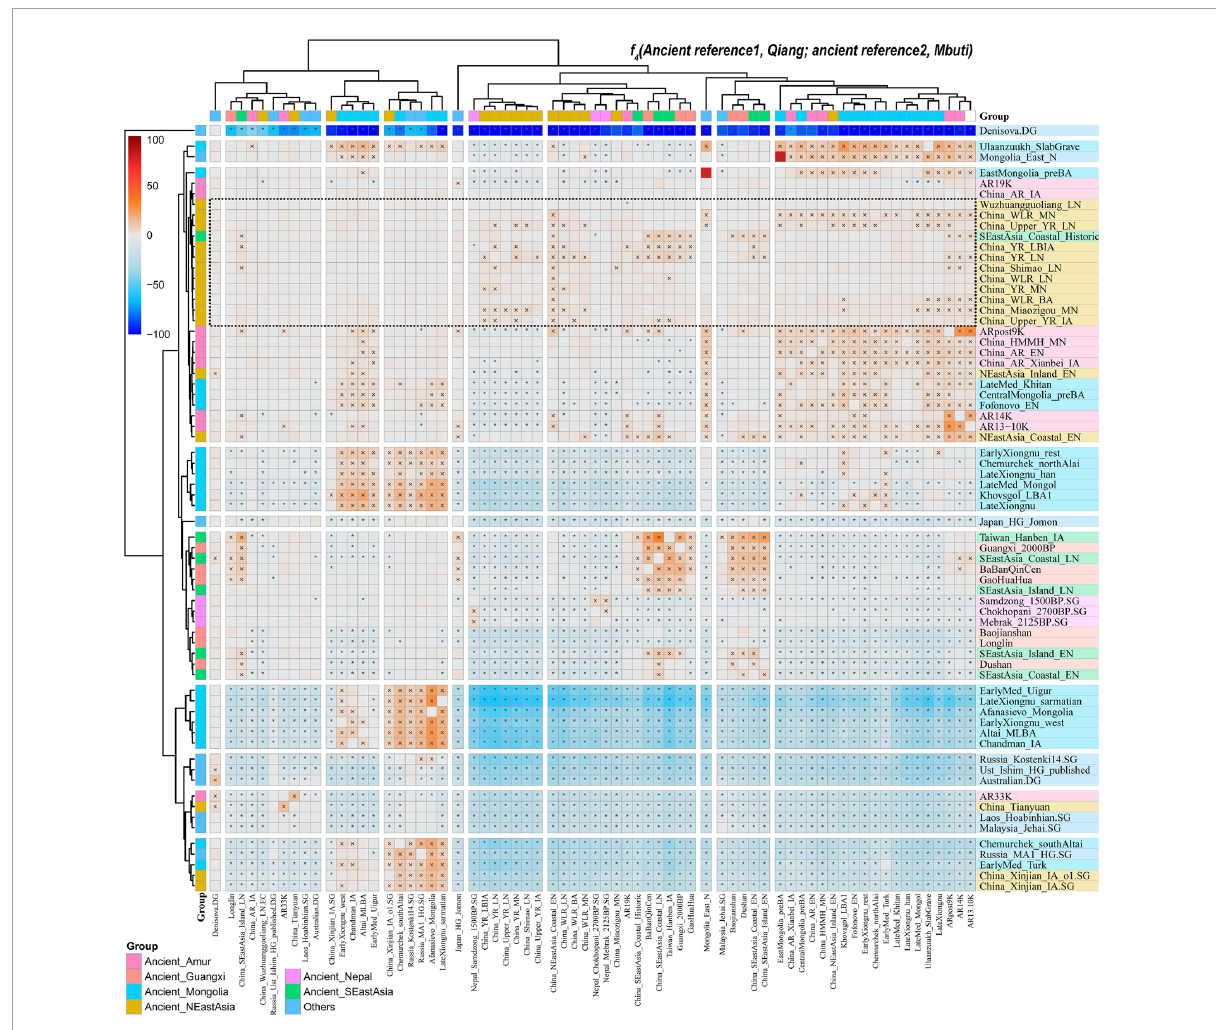
FIGURE7 Results from f 4 -statistics showed the genetic affinity between Qiang and northern East Asians. Statistically significant population pairs were marked with stars, and the red color showed that Qiang had a close relationship with the right populations compared to the bottom populations. Blue color with negative values means a close genetic relationship with bottom populations compared with the right